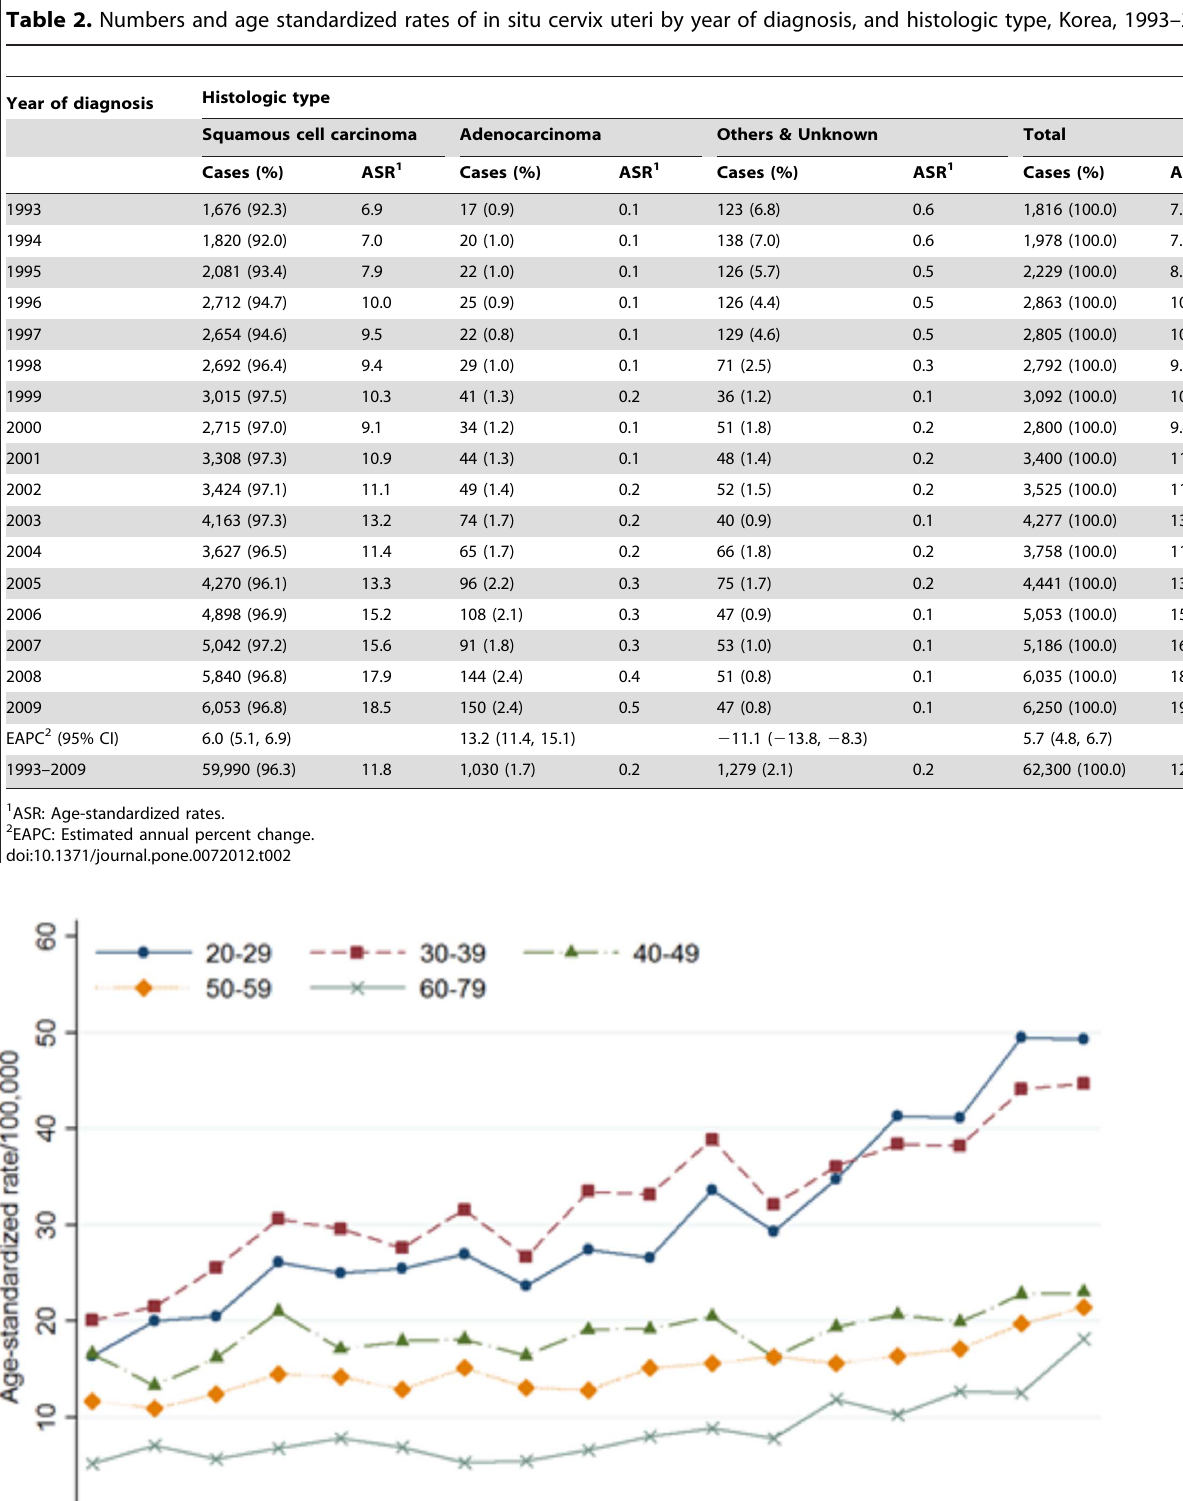
Table 2. Numbers and age standardized rates of in situ cervix uteri by year of diagnosis, and histologic type, Korea, 1993–2009.